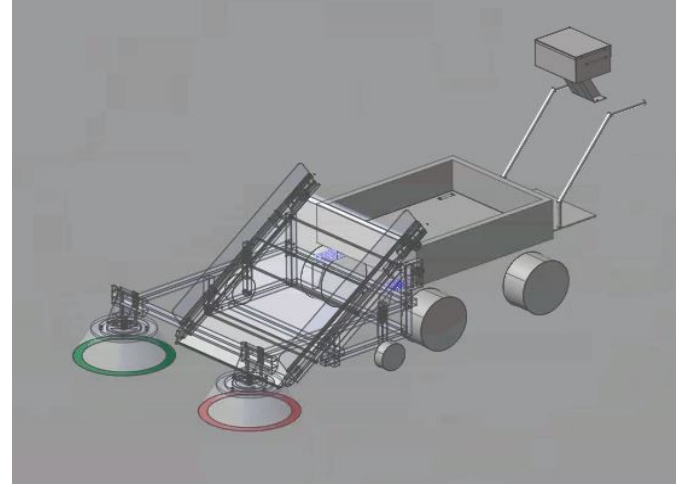
Table 1. Material properties for simulation.